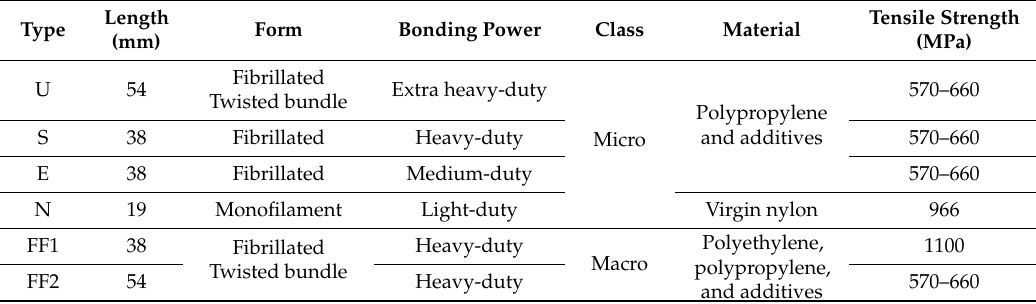
Table 1. Specifications for FORTA fibers. (U: Ultra-Net; S: Super-Net, E: Econo-Net; N: Nylo-Mono; FF: Ferro).